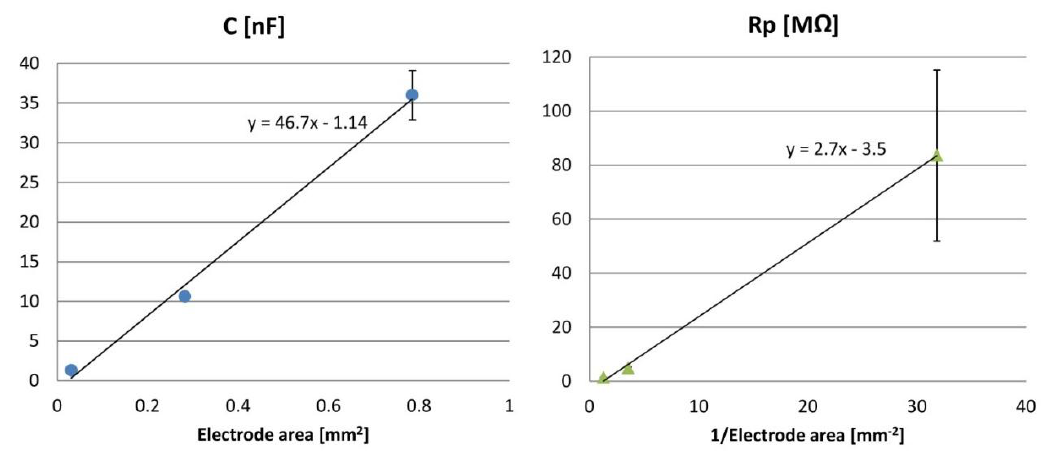
Figure 14. Values derived from Table 1 for the double layer capacitance C and charge-transfer resistance R p plotted against the electrode area.